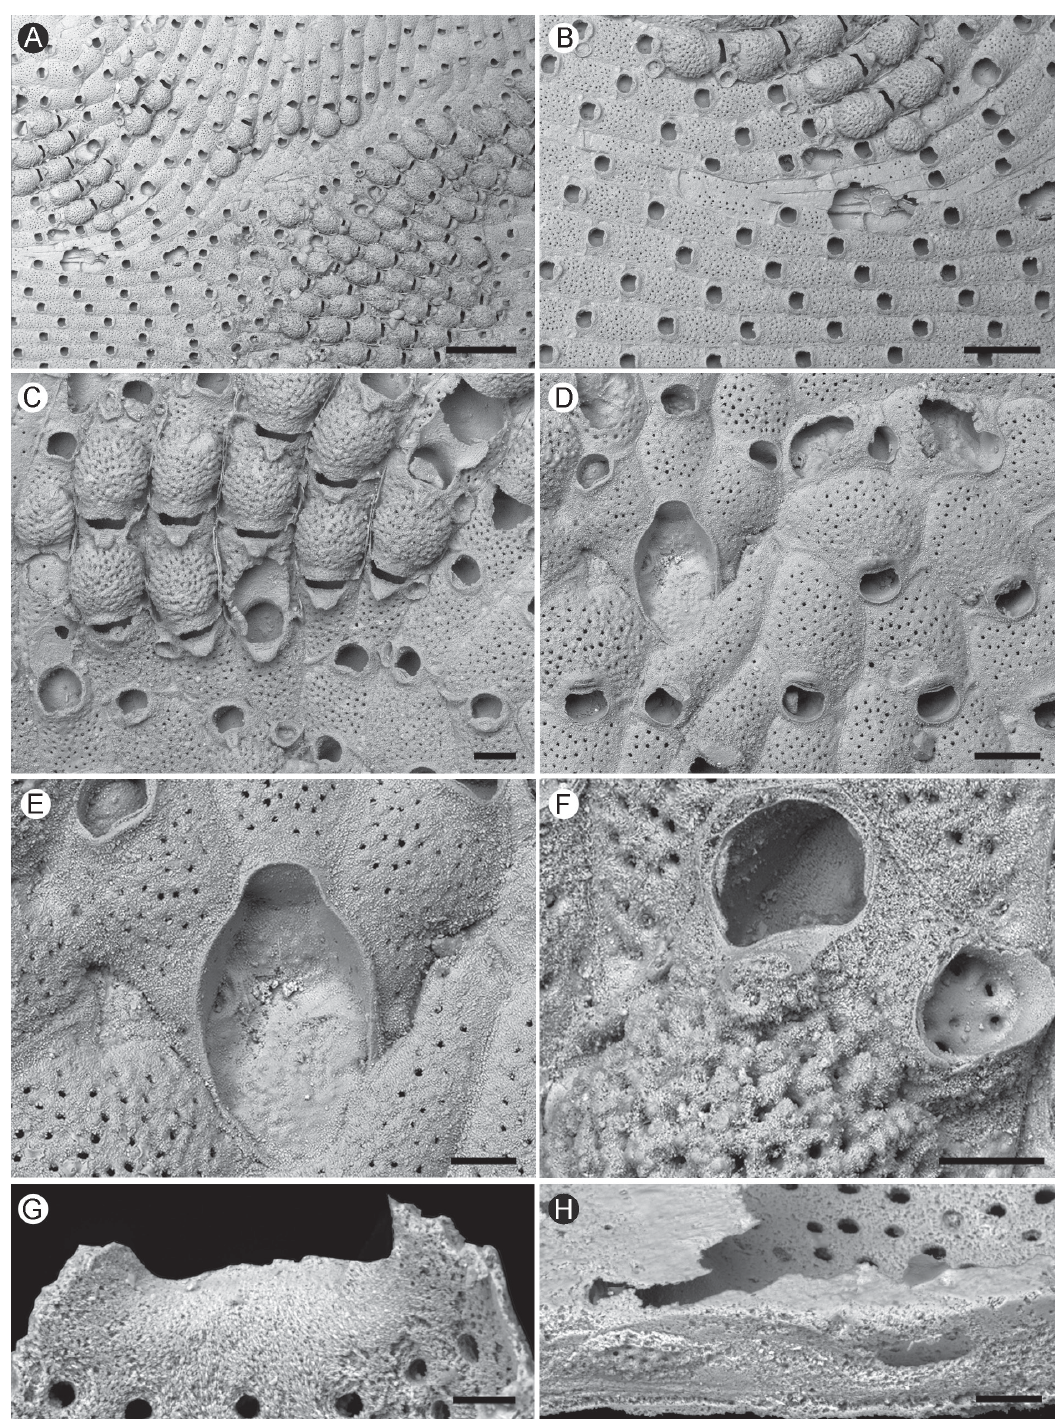
Fig. 6. Powellitheca waipukurensis (Waters, 1887) comb. nov. Nukumaruan, Pleistocene, Nukumaru Limestone, Waiinu Beach. A–F. NHMUK BZ 7744. A . General view of two colonies encrusting a bivalve shell. B . Fusion of the two colonies shown in A and formation of kenozooids along the encountering edge. C . Group of fertile zooids and autozooids. D . Ancestrula and early ontogeny. E . Close-up of the minimally calcified ancestrula. F . Autozooidal orifice and avicularium. — G–H . NHMUK BZ 7745. G . Internal view of the proximal, convex, orificial rim lacking a lyrula. H . Multiporous septula on the zooidal vertical walls. Scale bars: A = 1 mm; B = 500 µm; C–D = 200 µm; E–F = 100 µm; G–H = 20